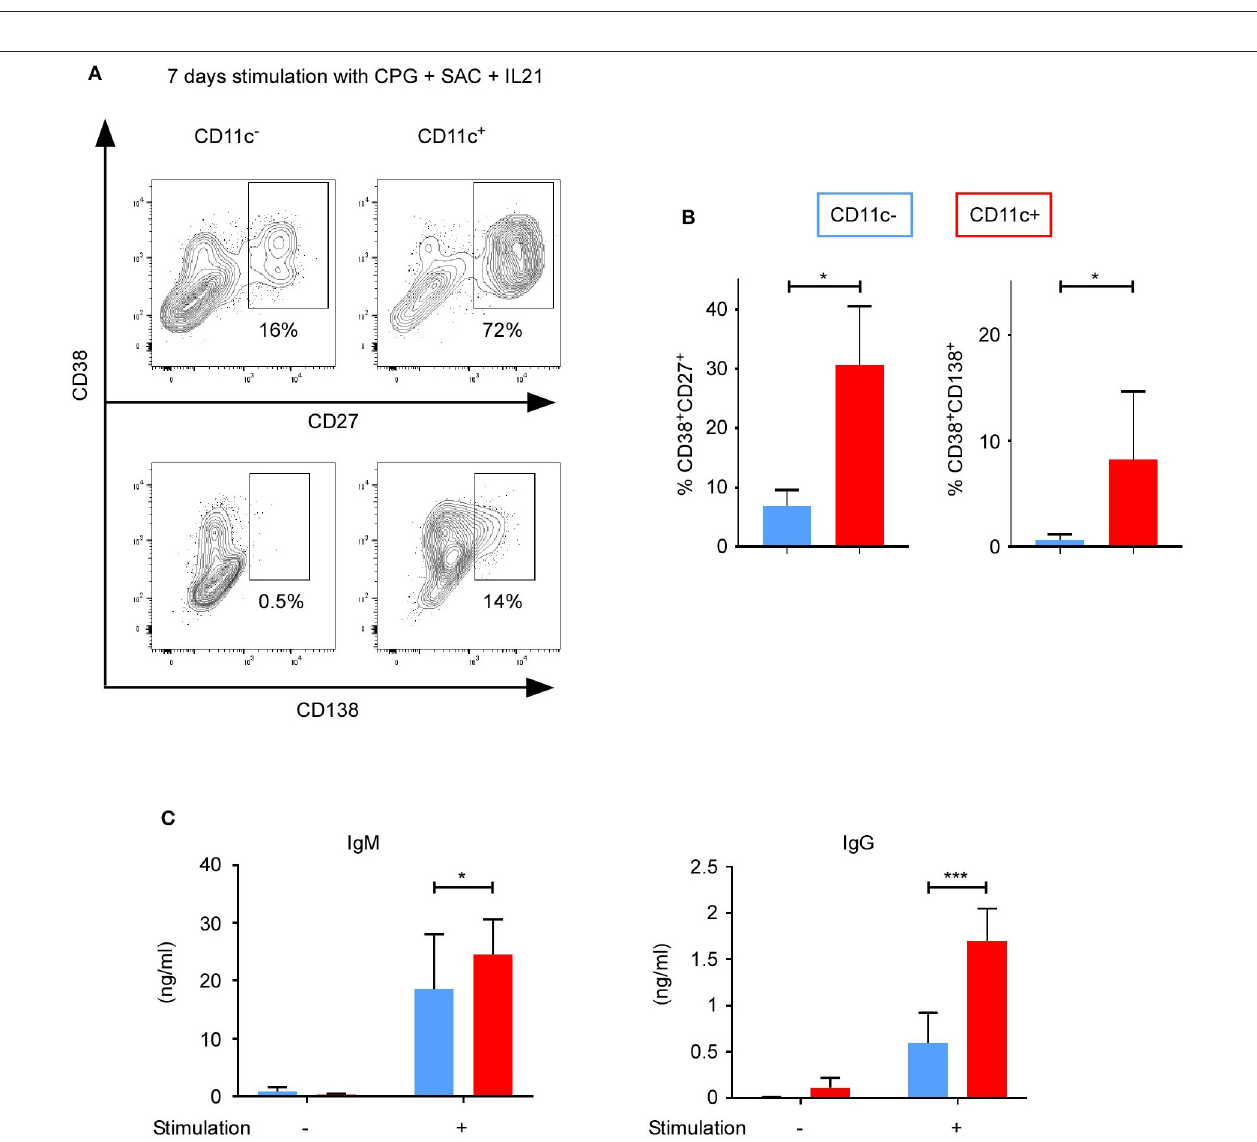
FIGURE 5 | cytokine genes. (C) CD11c + B cells upregulated CD27 , CD11b , and CD11c gene coding for cell surface markers compared to CD11c − B cells. (D) IRF5 gene expression level is shown. (E) Peripheral blood mononuclear cells (PBMC) from 10 HD were cultured in the presence of Brefeldin A for 4h, without any stimulation, and then stained intracellularly with antibodies specific for: Epstein–Barr virus-induced 3 (EBI3), interleukin (IL)-1 β , interferon gamma (IFN- γ ), IL-10, IL-6, and B-cell maturation antigen (BCMA). Percentage of cytokine expressing cells for CD11c + and CD11c − B cells are shown. Bar graphs show mean ± SEM of relative